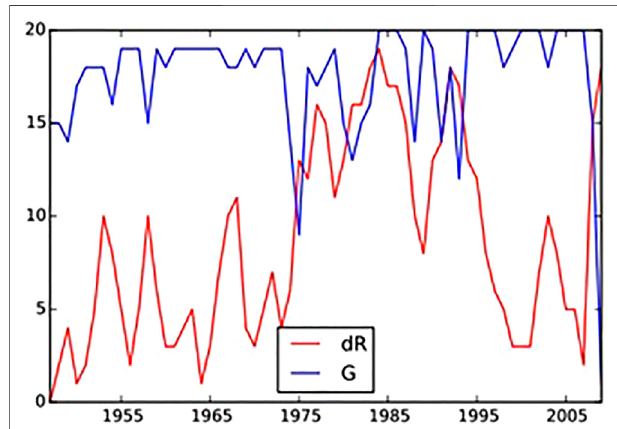
FIGURE2| Thesumofthediscretegrowthindicators(G)andthedebtto GDPratioindicators(dR)accordingtotheyear.Foragivendate,theindicators are calculated as the sum of the number of countries for which the direction of changecoincides. Alow value therefore indicates heterogeneous overall dynamicsand avalueclosetothesamplesizeindicates homogeneous overall